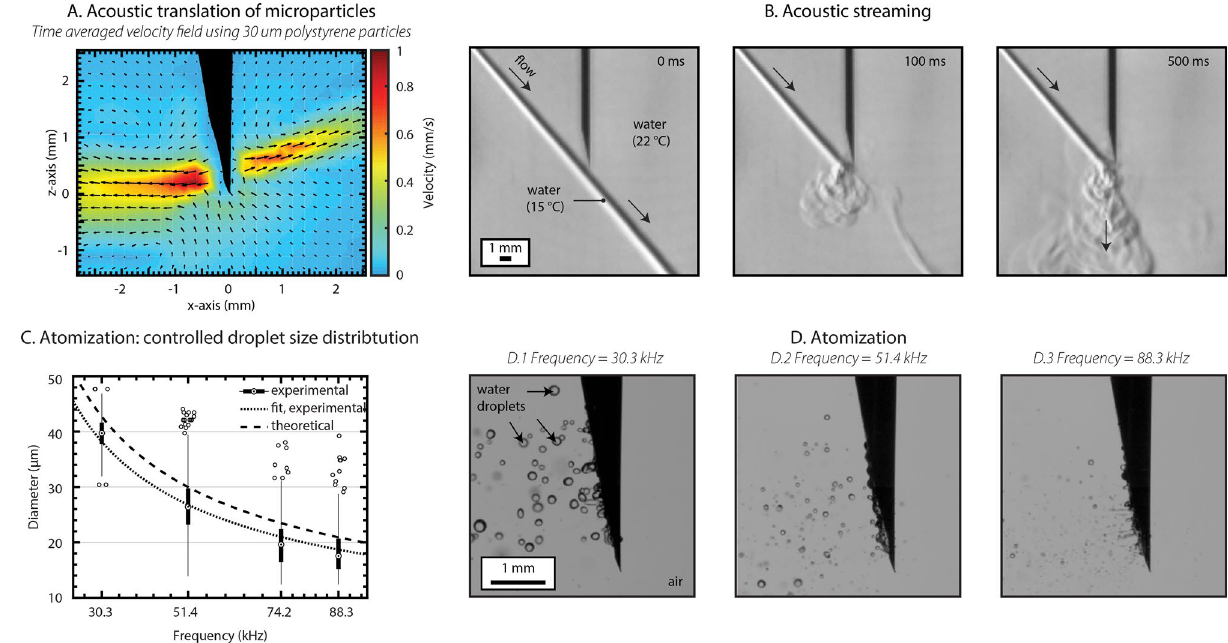
Figure 2. ( A ) 30 µ m diameter polystyrene microparticles were used to visualize the water flow pattern around the needle during sonication. The graph represents the time-averaged velocity field of the particles, calculated across a time window of 100 ms. ( B ) Schlieren images show the disturbance of water laminar flow induced